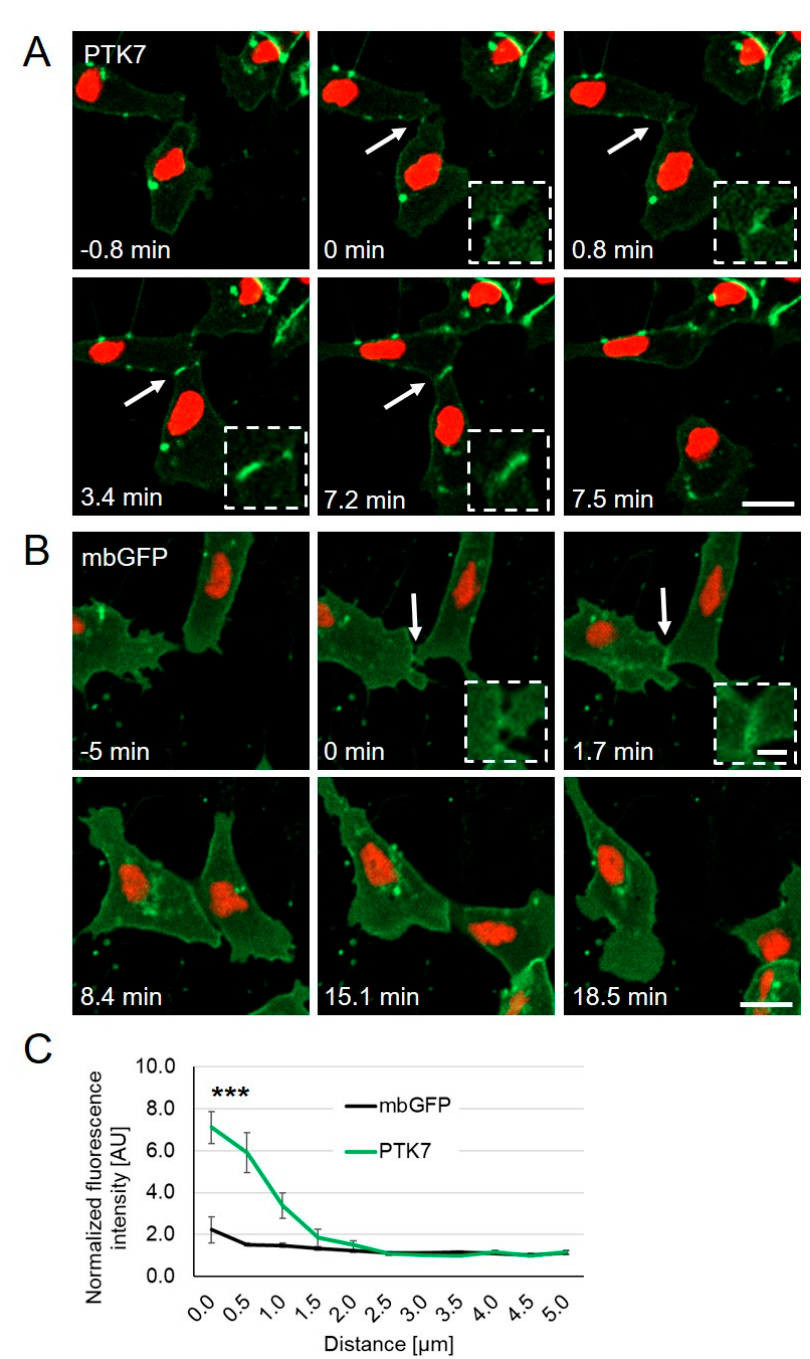
Figure 1. PTK7-GFP accumulates at cell–cell contact sites; Xenopus embryos were injected with 250 pg PTK7-GFP or 50 pg mbGFP RNA in combination with 250 pg H2B-mcherry RNA into one blastomere at the two-cell stage. NC cells were explanted at stage 17 and analyzed by spinning disk microscopy. ( A ) Time lapse images of PTK7-GFP expressing NC cells before (–0.8 min), during (0–7.2 min), and after (7.5 min) cell collision. The dashed square shows a higher magnification of the NC cell–cell contact zone. PTK7-GFP is highly enriched at the contact zone between NC cells, but immediately disappears when the cell–cell contacts are broken. NC cell–cell contacts are indicated by white arrows and are shown at higher magnifications in the boxed areas. Scale bar = 20 µ m or 5 µ m for higher